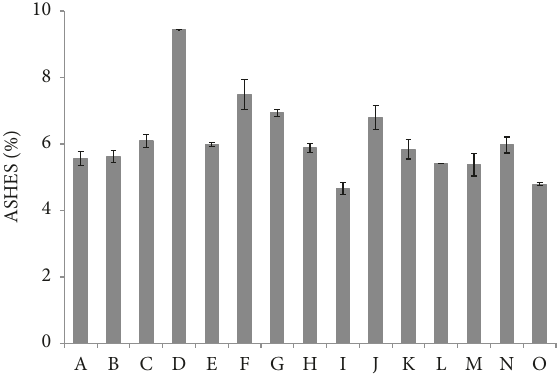
Figure 1: Ash content of the roasted ground coffee